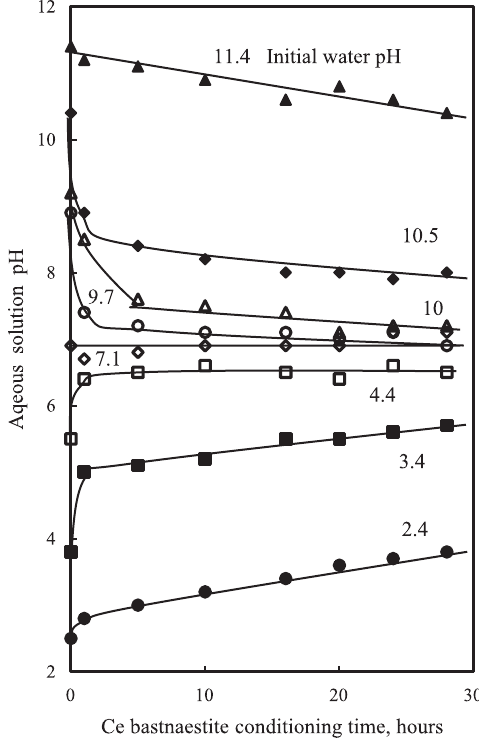
Fig. 1 Change of pH with conditioning time for the synthetic cerium bastnaesite/water